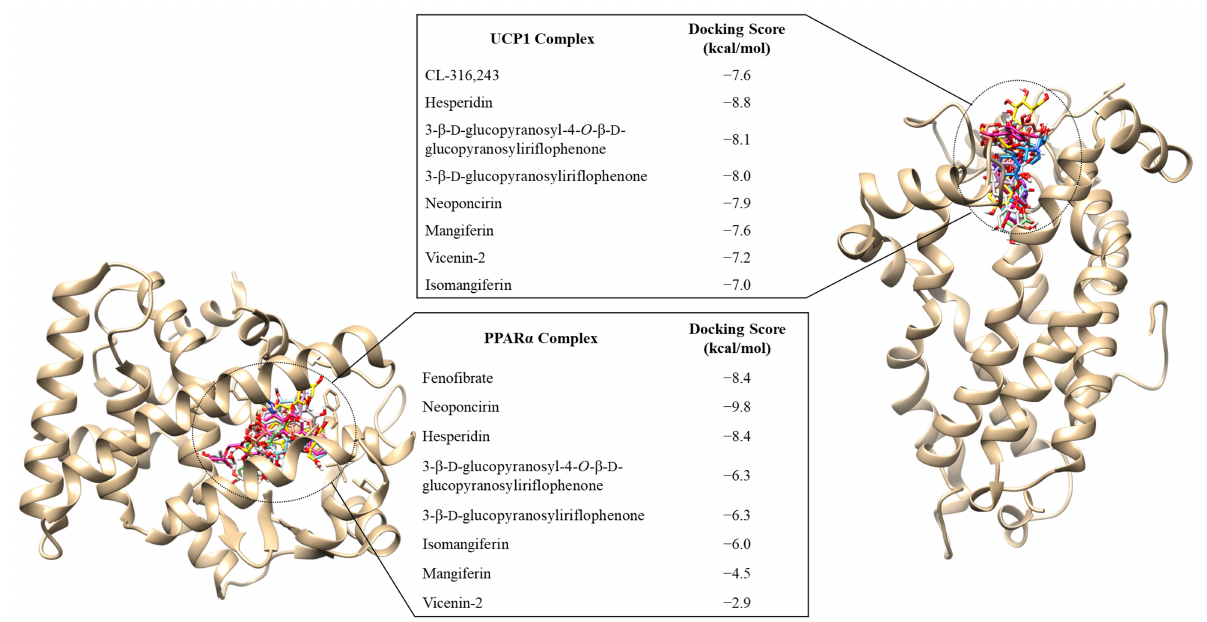
Figure 6. In silico binding affinity scores and superimposed docked complexes of CPEF phenolic Figure 1. Figure 1. compounds bound to target proteins, PPAR α ( left ) and UCP1 ( right ). The experimental standard, fenofibrate, docked to PPAR α with a binding energy of − 8.4 kcal/mol, while neoponcirin and hesperidin docked with binding affinities of − 9.8 kcal/mol and − 8.4 kcal/mol, respectively. The known drug, CL-316,243, bound to the active site of UCP1 with a docking score of − 7.6 kcal/mol, while hesperidin docked with a binding affinity of − 8.8